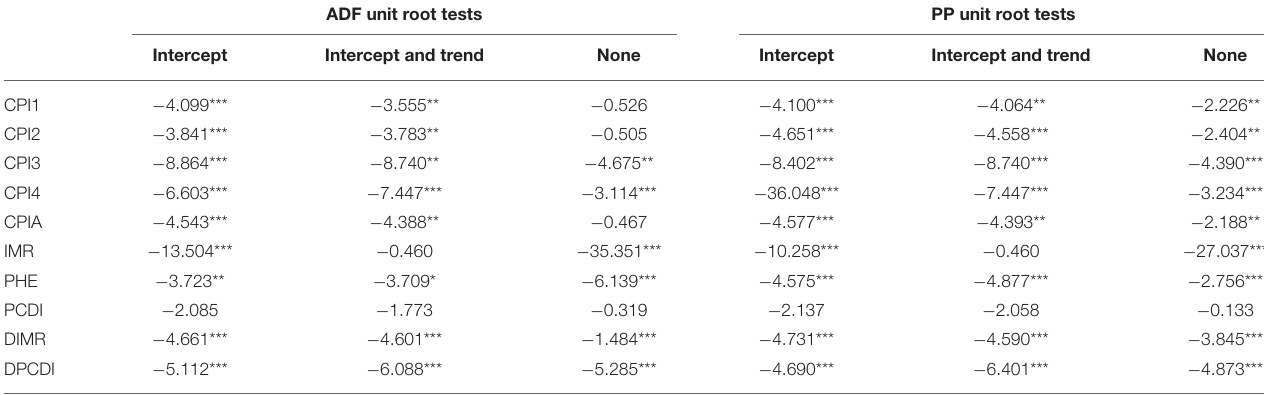
TABLE 2 | Unit root test.